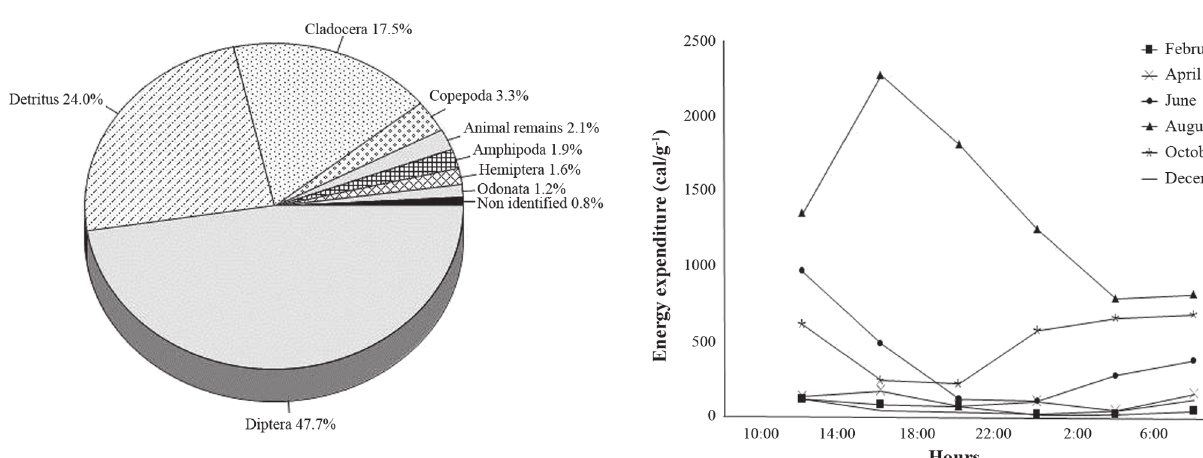
Fig. 8. Percentages of each food components found in the digestive tract of G. multiradiatus during a hydrological cycle in san Martín dam.